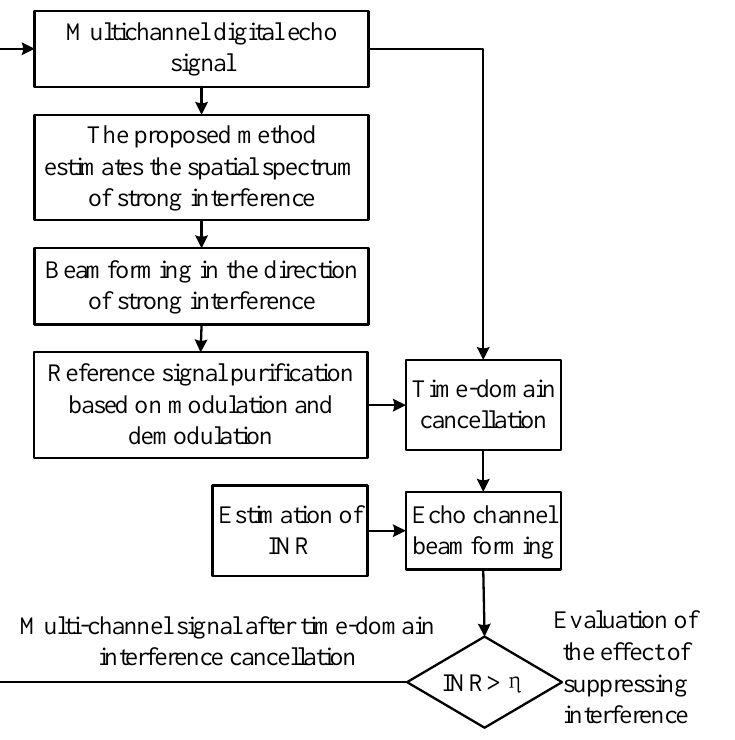
Figure 14. The measured data processing process. The range-Doppler cross-correlation (RDCC) is performed directly on the original echo signal and Figure 15 shows the result of RDCC.